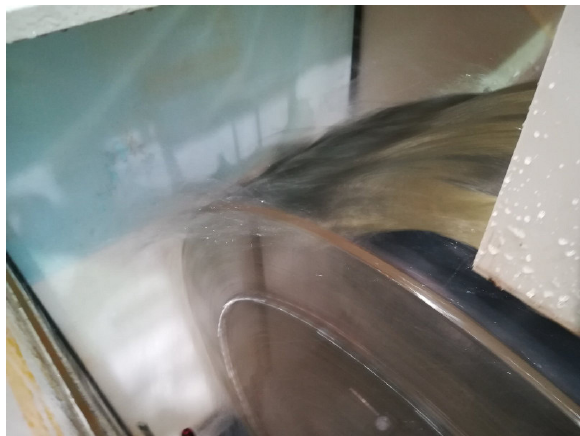
Fig. 16. Volumetric losses for high flow rates.